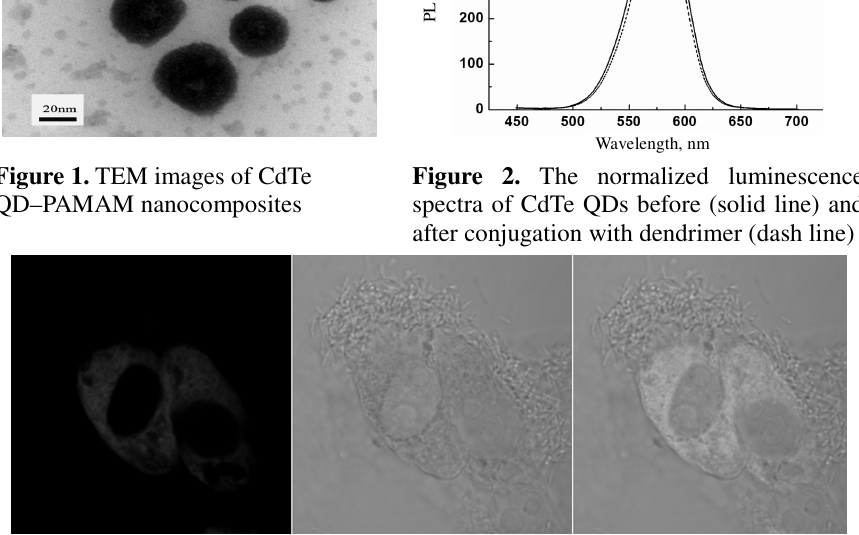
Figure 3. Confocal images of fixed PK15 cells incubated with CdTe-dendrimer nanoprobe